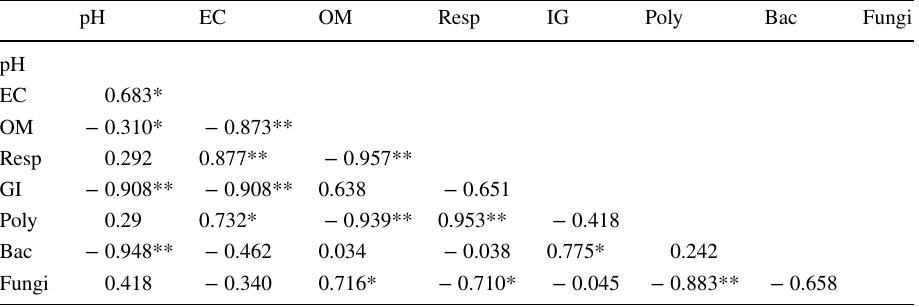
Table 8 Correlation matrix (Pearson’s r values) between the different parameters determined in soils subjected to the two different treatments